Question: In one sentence, what is this figure communicating?
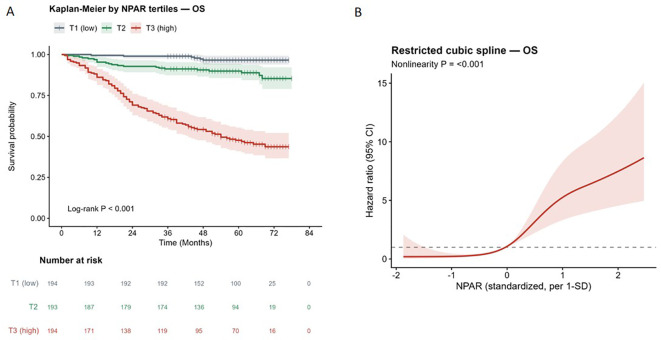
Answer: Prognostic value of NPAR for overall survival (OS). (A) Kaplan–Meier curves for overall survival stratified by NPAR tertiles. (B) Restricted cubic spline showing the association between standardized NPAR and overall survival risk.